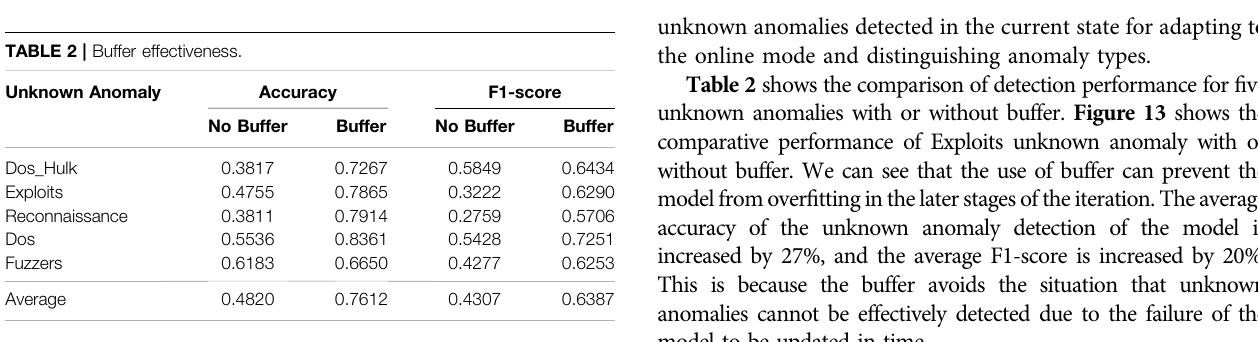
Frontiers in Computer Science |